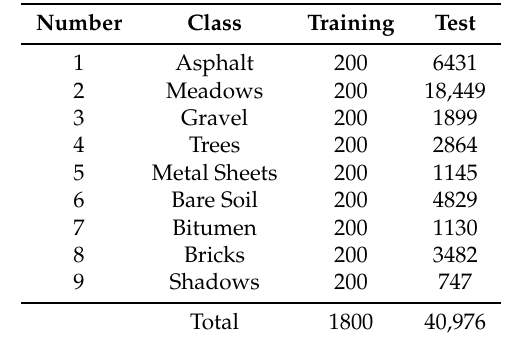
Figure 7. 3D cubes of Pavia University and Indian Pines. Table 1. Number of training (labelled) samples and test (unlabelled) samples in the Pavia University dataset.